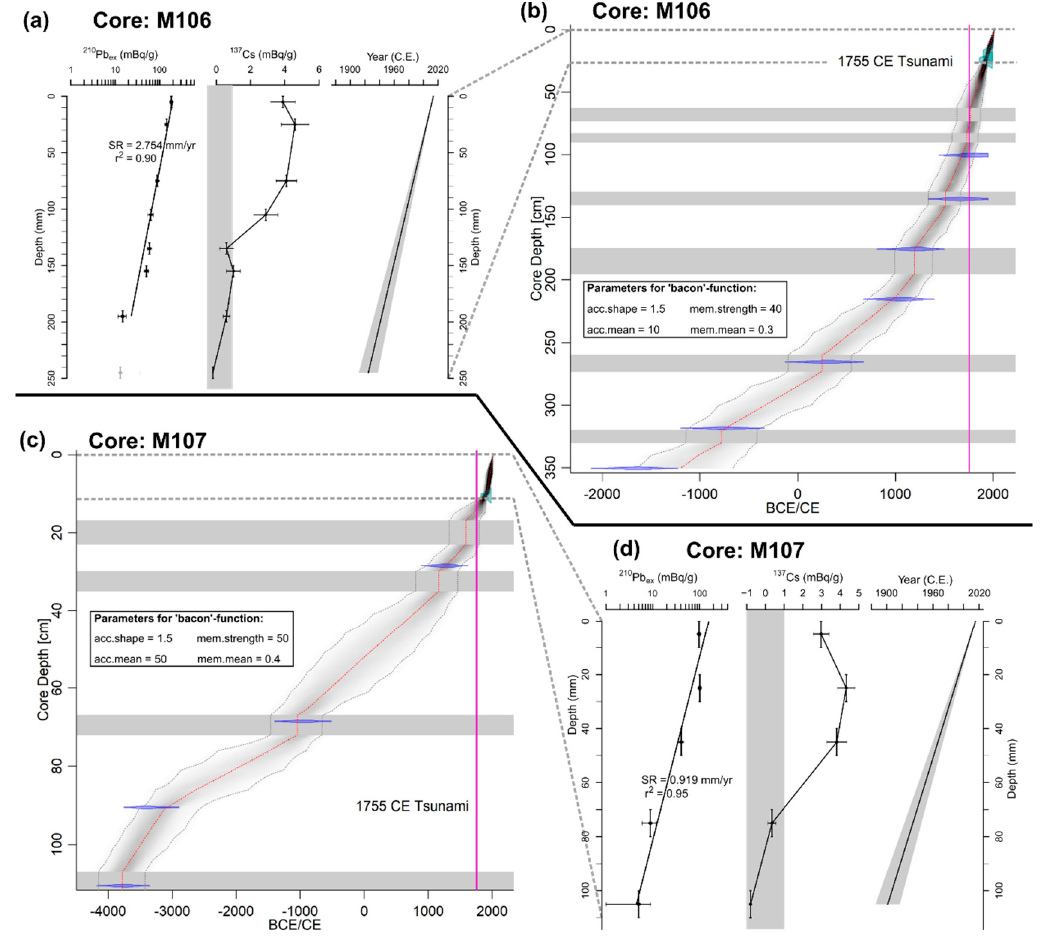
Figure 4. Age-depth relation of core M106 and M107. ( a , d ) Profiles and age-depth relation using 210 Pb-ages (“serac” output). SR = sedimentation rate. Grey vertical bar indicates 137 Cs values that are negligible. ( b , c ) Age-depth relation using 210 Pb xs and 14 C method (“rbacon” output) including calibrated 14 C-ages (blue). The red curve shows a single “best” model based on the weighted mean age for each depth. Darker grey indicates CE-ages that are more likely and dashed grey lines represent the 95% confidence intervals (max. and min. CE-ages). Horizontal grey bars represent possible high energy event layers (abrupt sedimentation) detected by a previous study (see Section 1.2, [60]). Age model parameters are shown for better reproducibility.